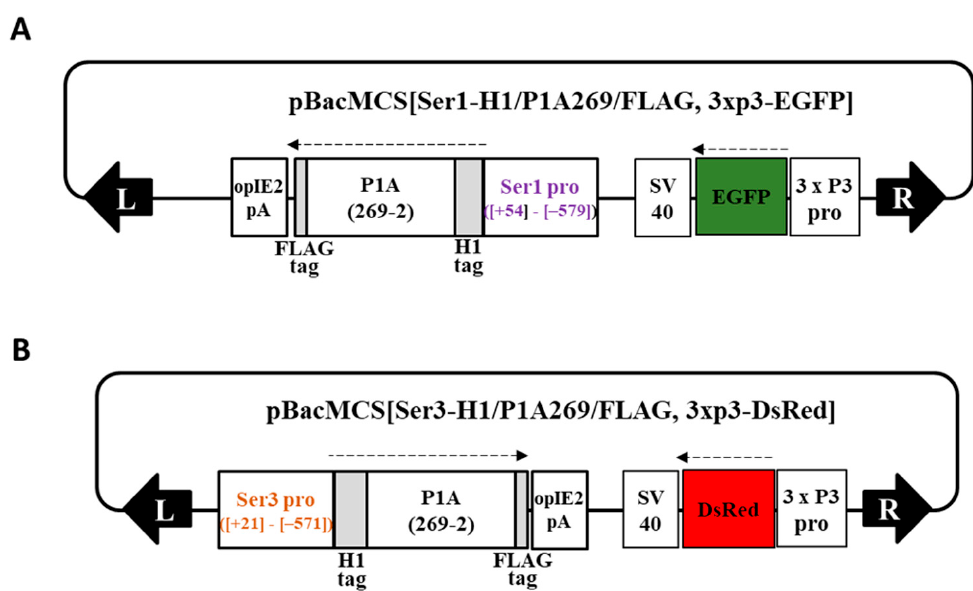
Figure 1. Schematic representation of the donor plasmids. ( A ) pBacMCS[Ser1-H1/P1A269/FLAG, 3 x P3-EGFP] and ( B ) pBacMCS[Ser3-H1/P1A269/FLAG, 3 x P3-DsRed] containing designed sequences expressing the pierisin-1A (P1A) catalytic domain under the control of the Ser1 and Ser3 promoters, respectively, along with the genetic markers. The numbers indicate the nucleotide position of the gene promoter sequence [29,30] and 2–269 amino acid positions of P1A [20]. Black arrows indicate the piggyBac inverted terminal repeat (ITR) at the left and right arms; broken arrows indicate the direction of the translation.